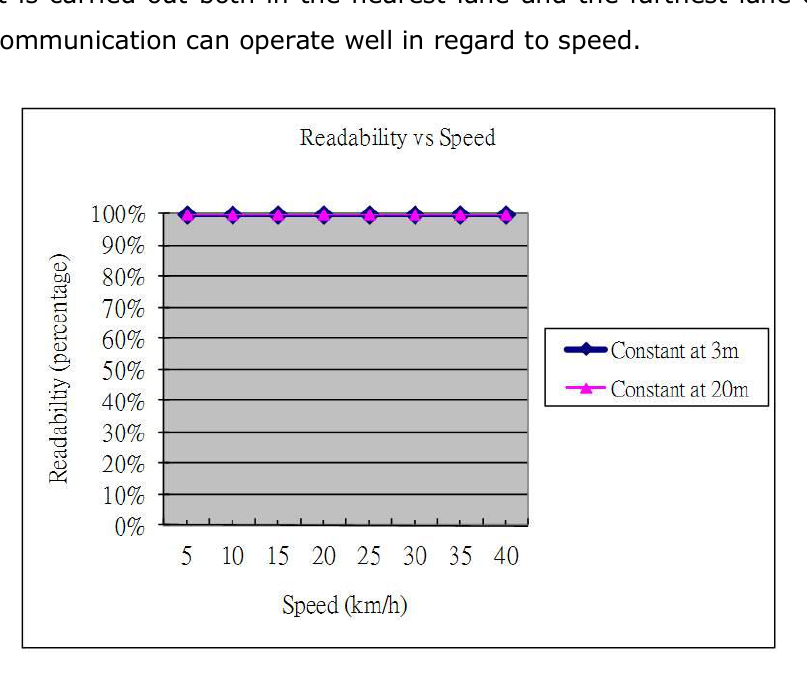
Figure 15. Relationships between readability and